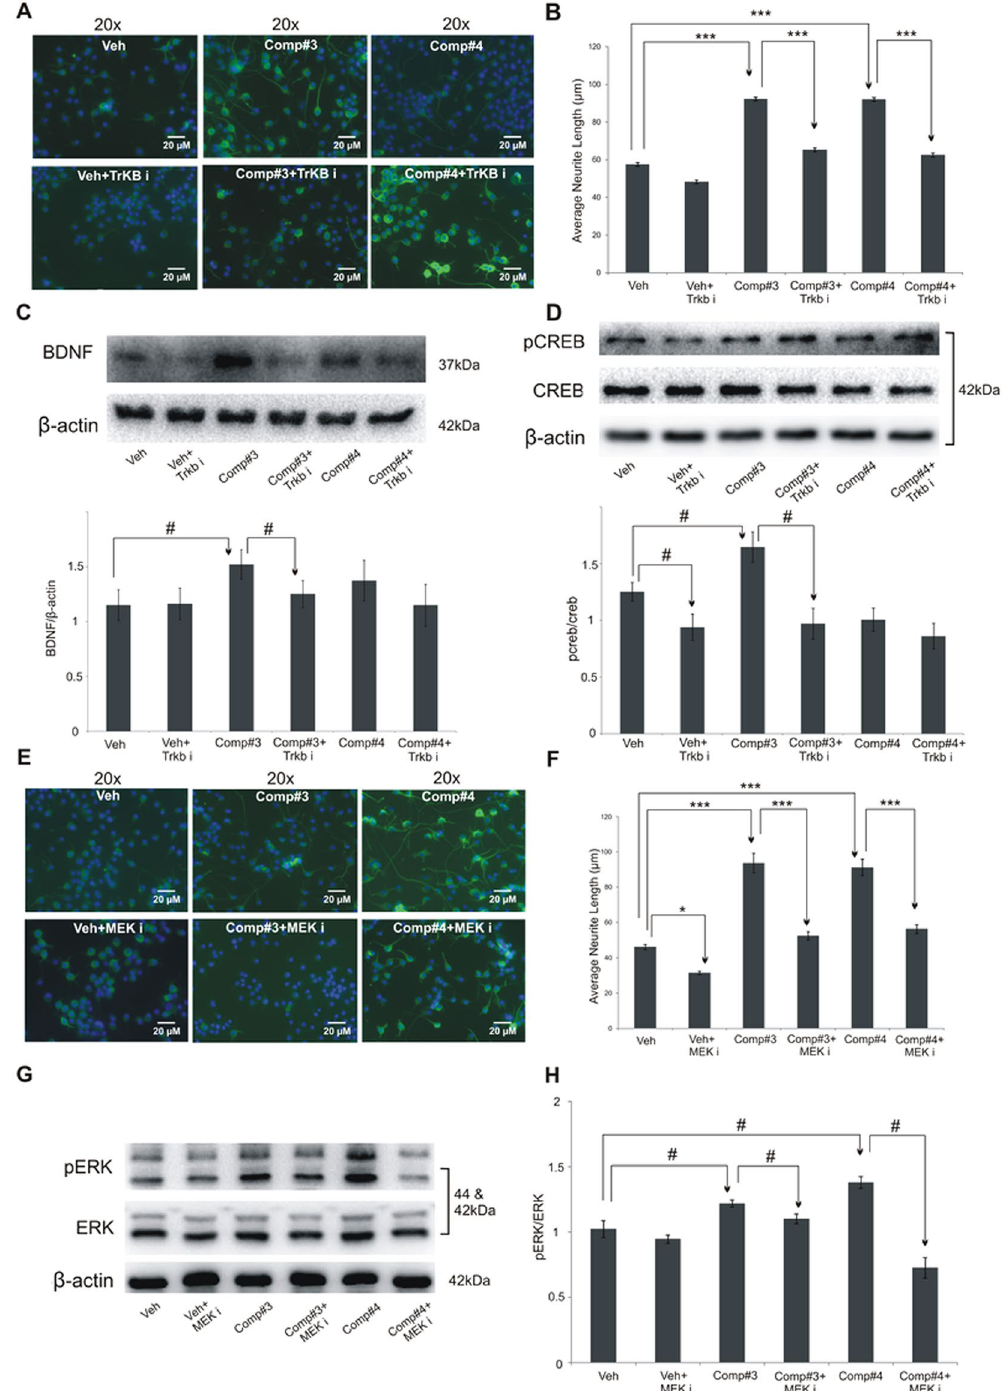
Figure 7. Mechanistic studies of compounds in vitro with MEK and TrkB inhibitor. Morphometric analysis of neurite outgrowth in differentiated Neuro 2A cells treated with #3(0.01 μ M) and #4(0.01 μ M), pre-treated with or without MEK and TrkB inhibitor, PD98059 (20 μ M) and ANA-12 (10 μ M), respectively ( A,B and E,F ). Protein expression of BDNF ( C ) and pCREB-CREB ( D ) in Neuro2A cells treated with #3(0.01 μ M) and #4(0.01 μ M) in TrkB inhibitor pre-treated cells. Similarly, protein expression of pERK-ERK ( G,H ) was evaluated in MEK inhibitor pre-treated Neuro2A cells. Values are represented as mean ± SE with n = 3; Results analysed by either one-way ANOVA followed by post hoc Tukey test ( A,B and E,F ) represented as ( * ) or two-tailed unpaired student’s t-test for pairwise comparison between various groups represented as ( # ) where # p < 0.05 and *** p <